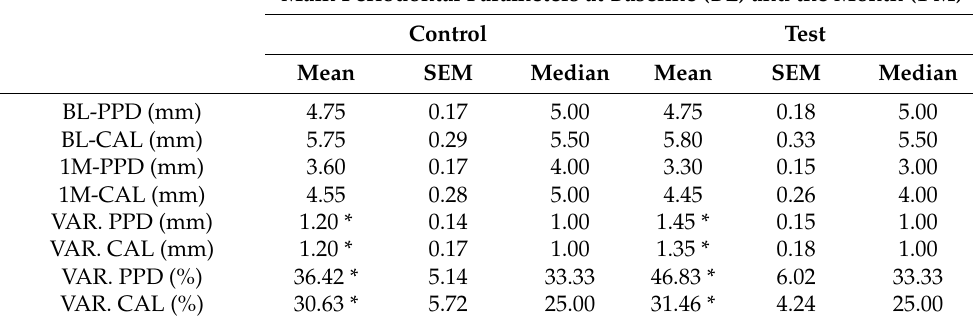
Table 1. Effect of the intervention on periodontal status.